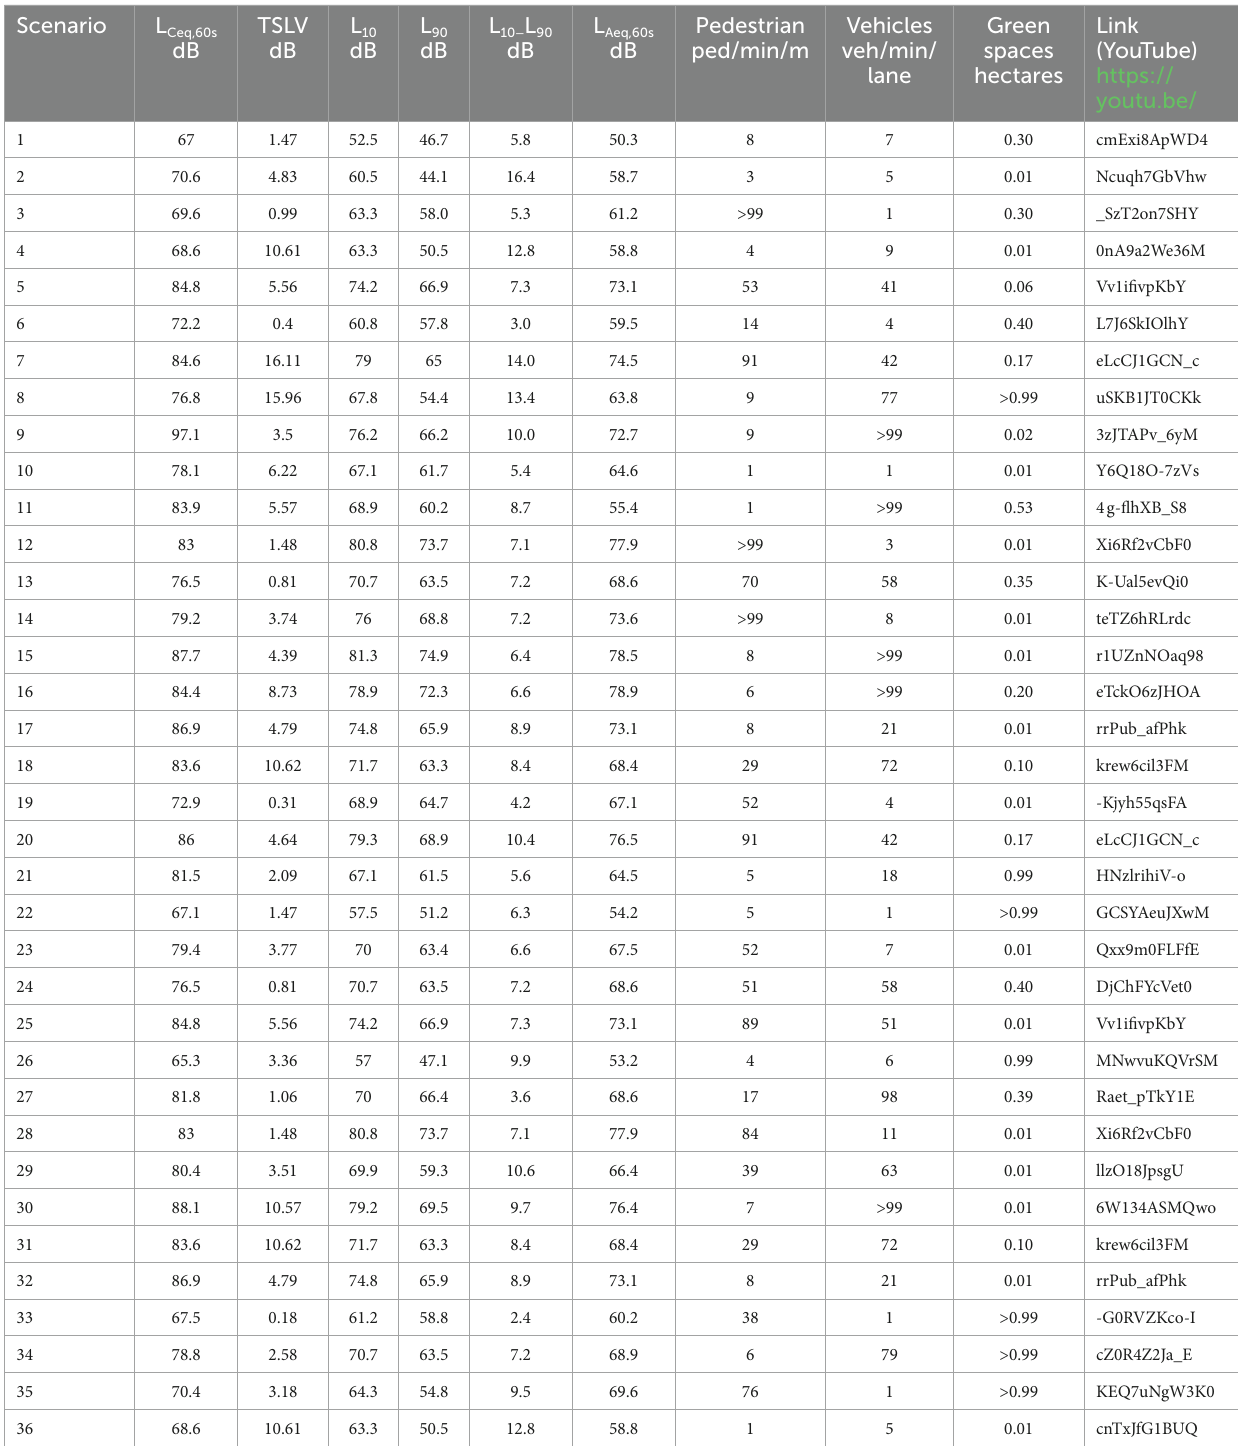
TABLE 4 Sound-visual value